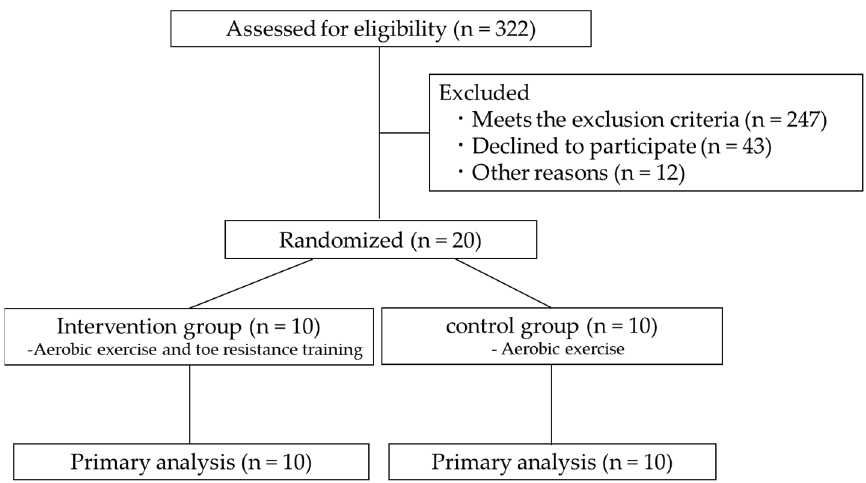
Figure 1. Flow diagram of the study, which included chronic hemodialysis patients with type 2 diabetes.